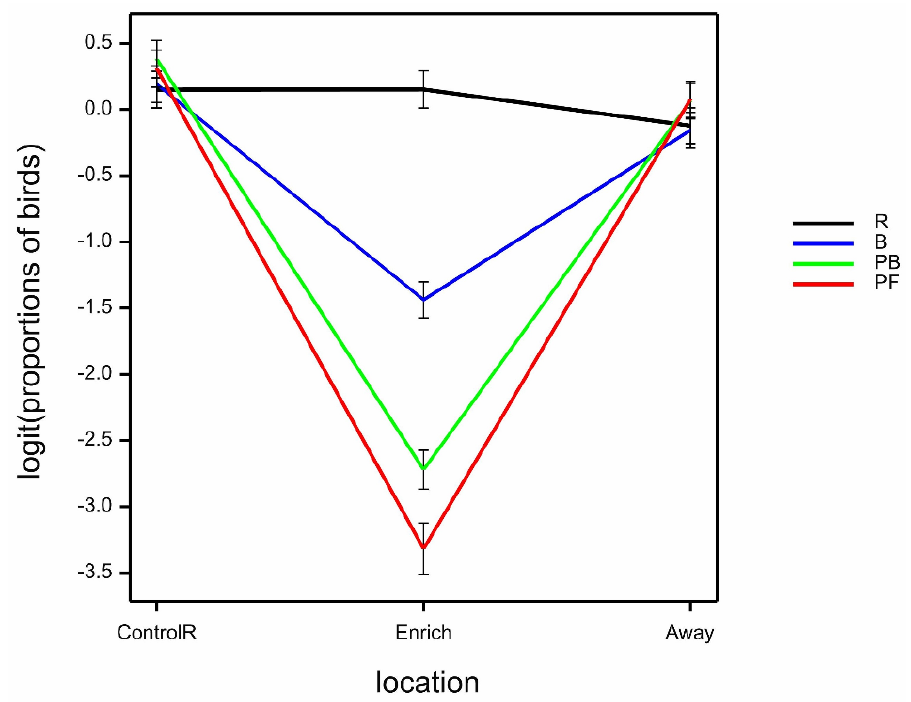
Figure 6. Mean ± SE logit (proportions of birds) observed in stand/sit behaviour, according to loca- tion (ControlR, Enrich, Away) and treatment (R, B, PB, PF), estimated from